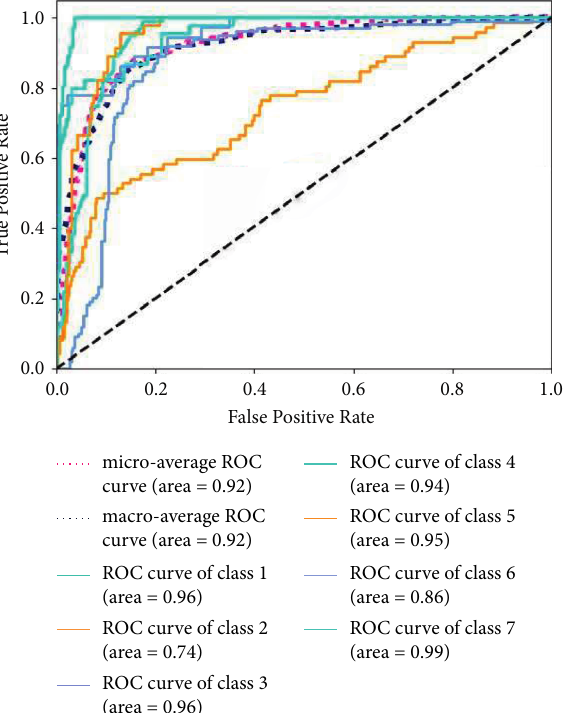
Figure 15: ROC curves of 7 classes of samples on